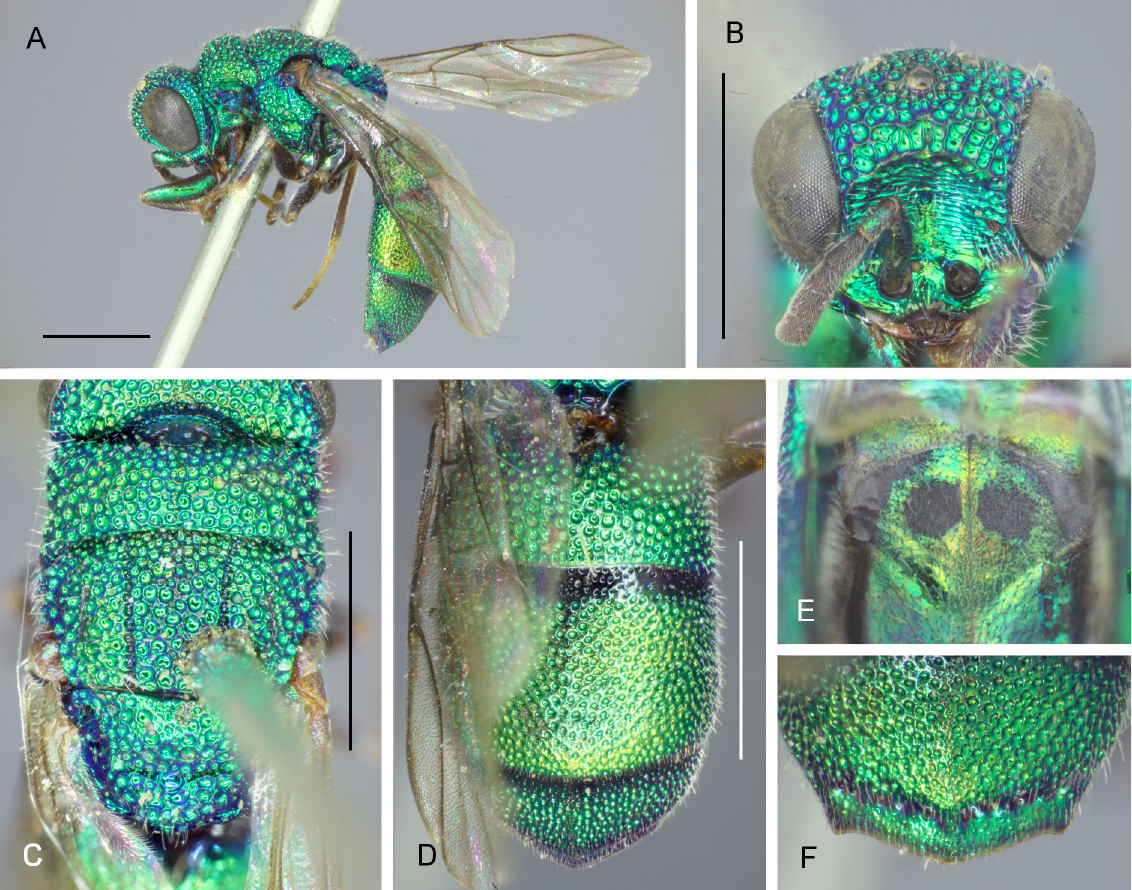
Fig. 7. Chrysidea phoebe Zimmermann, 1956, ♂. A . Lateral habitus. B . Head. C . Mesosoma. D . Metasoma. E . Black spots on S2. F . T3. Scale bars = 1.0